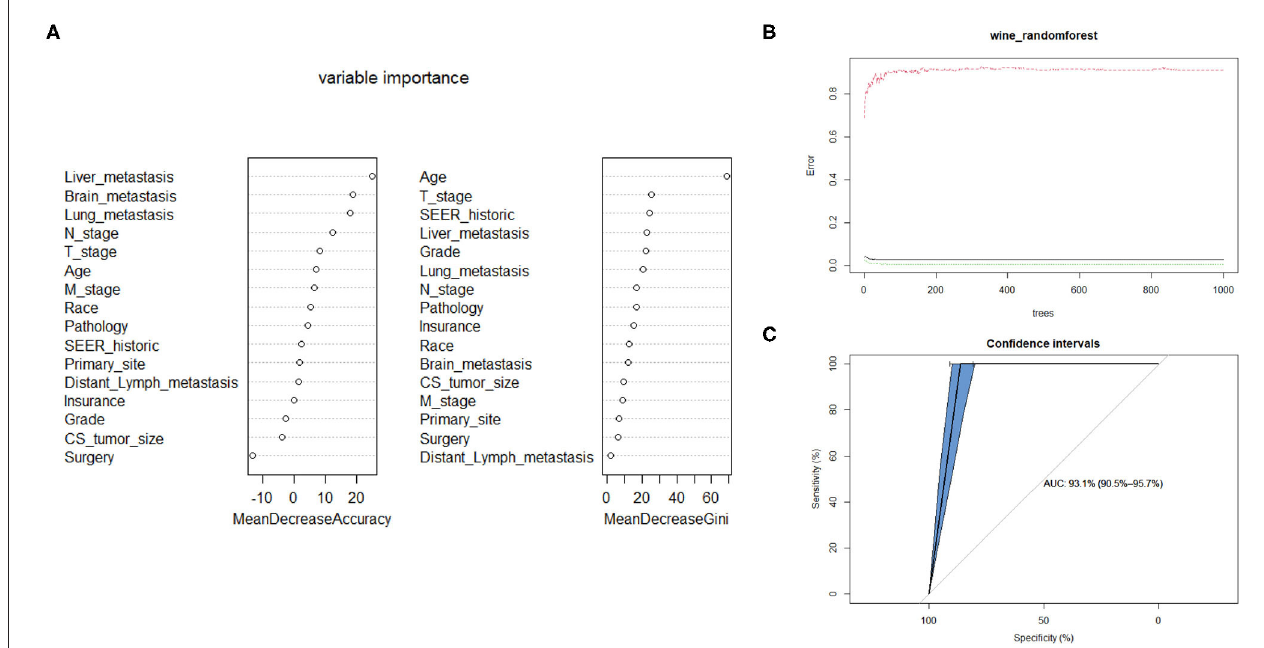
FIGURE 3 | Random forest model. (A) The candidate factors associated with micrometastasis of lymph nodes were ordered according to the mean decreased Gini index. (B) Relationship of dynamic changes between the prediction error and the number of decision trees. (C) Performance of the prediction model with increasing numbers of features in the ROC